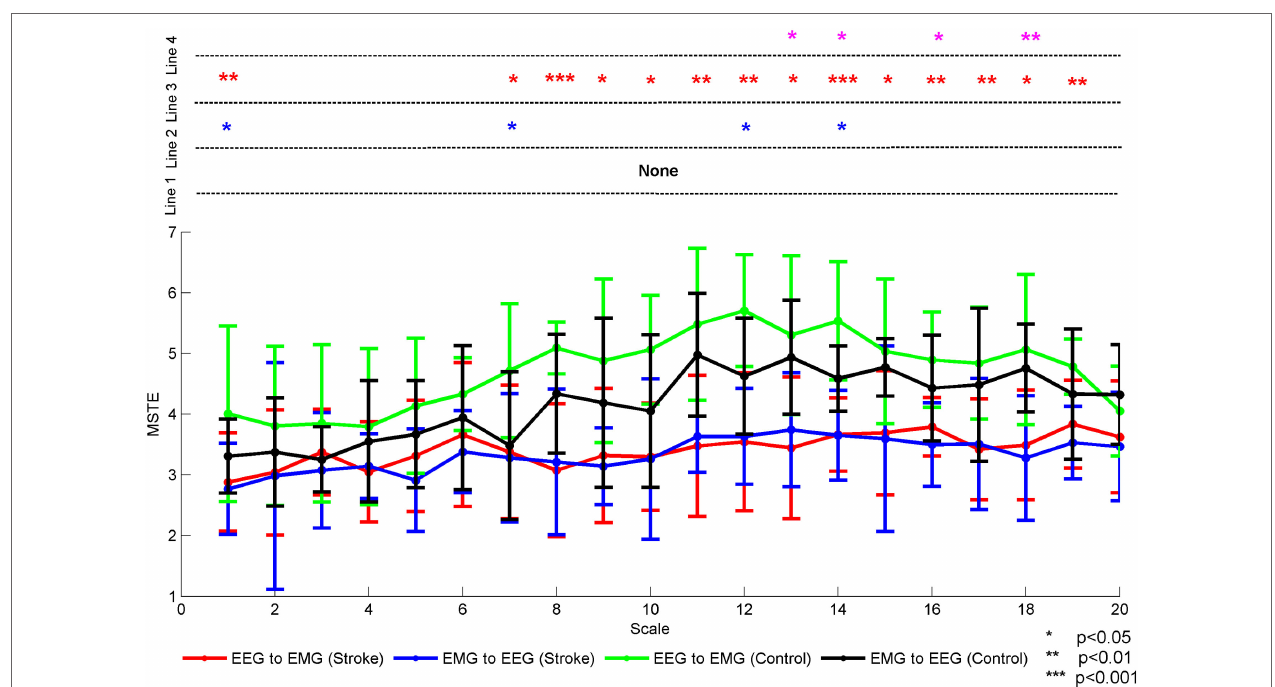
FIGURE 4 | The mean MSTE values in both directions for both stroke patients and healthy controls with the time scale increasing. We denoted the significance with the star mark. * p < 0.05, ** p < 0.01, and *** p < 0.001. The word “Line 1” showed the significant level between descending and ascending direction in each time scale for stroke patients, the word “Line 2” was for healthy controls. The Line 3 and Line 4 indicated the significant level between stroke patients and healthy controls at each time scales in descending and ascending directions, respectively.